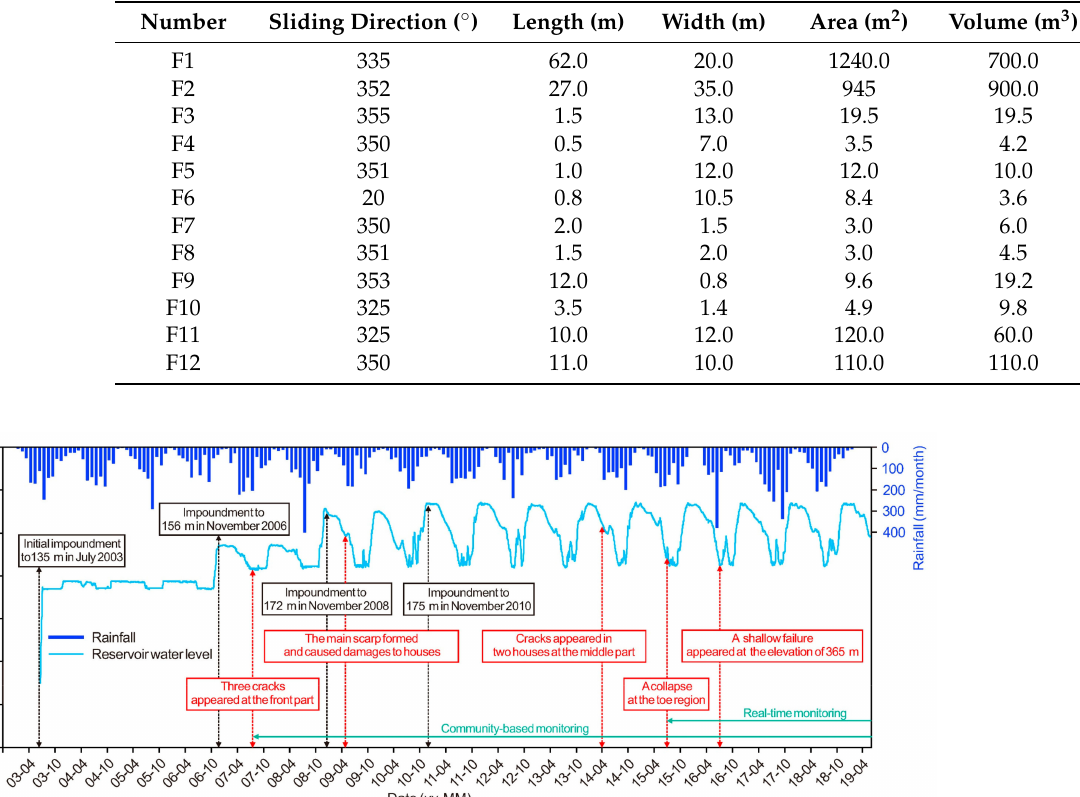
Table 2. Characteristics of small failures on the surface of the Ganjingzi landslide.